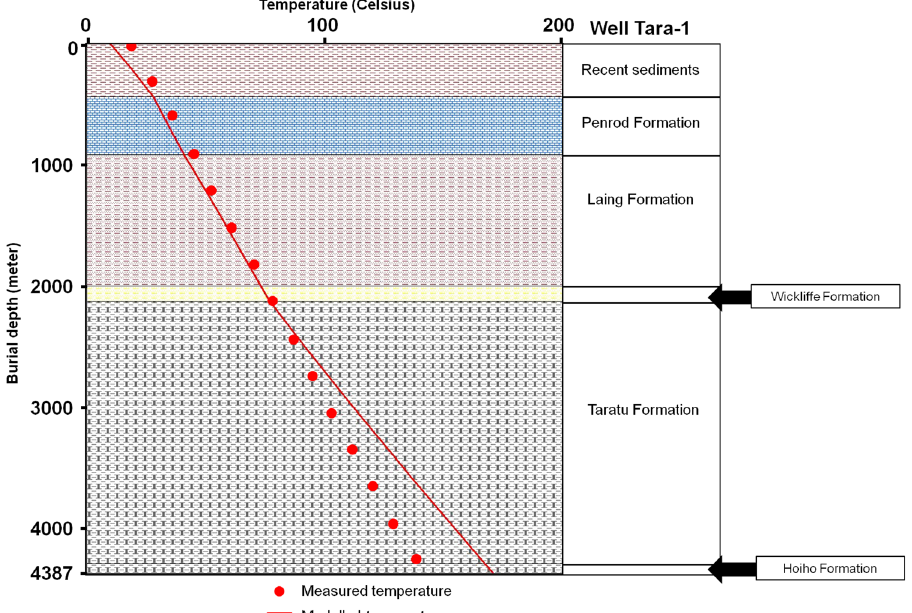
Fig. 13 Calibration of measured and modeled temperature for Tara-1 well